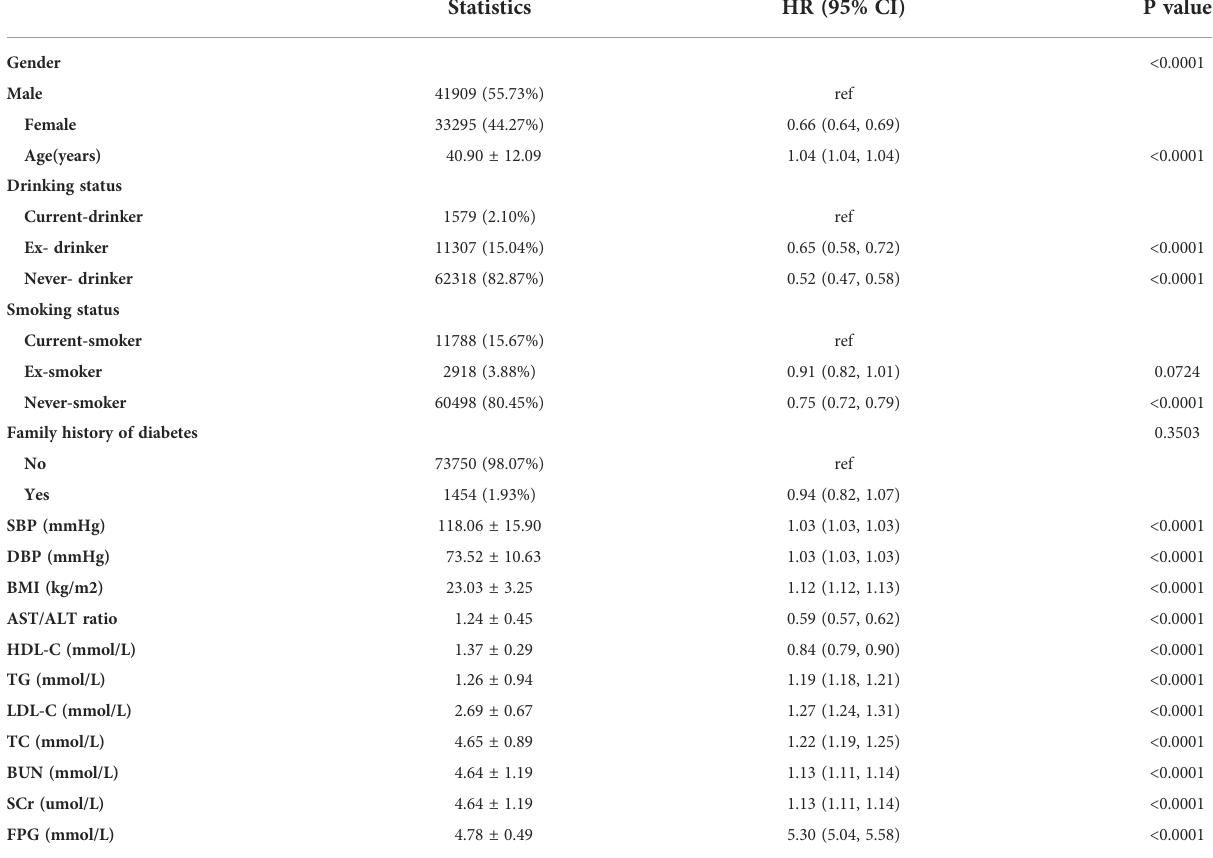
TABLE 3 The results of univariate analysis.